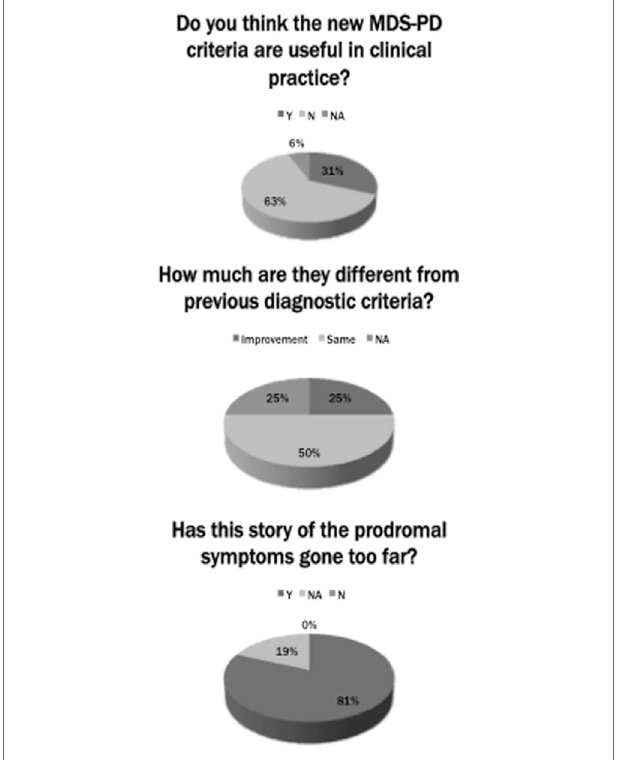
FiGURe 2 | Schematic representation of the senior movement disorder experts’ answers to the three questions of the brief survey. Legend: Y, yes; N, no; NA, not